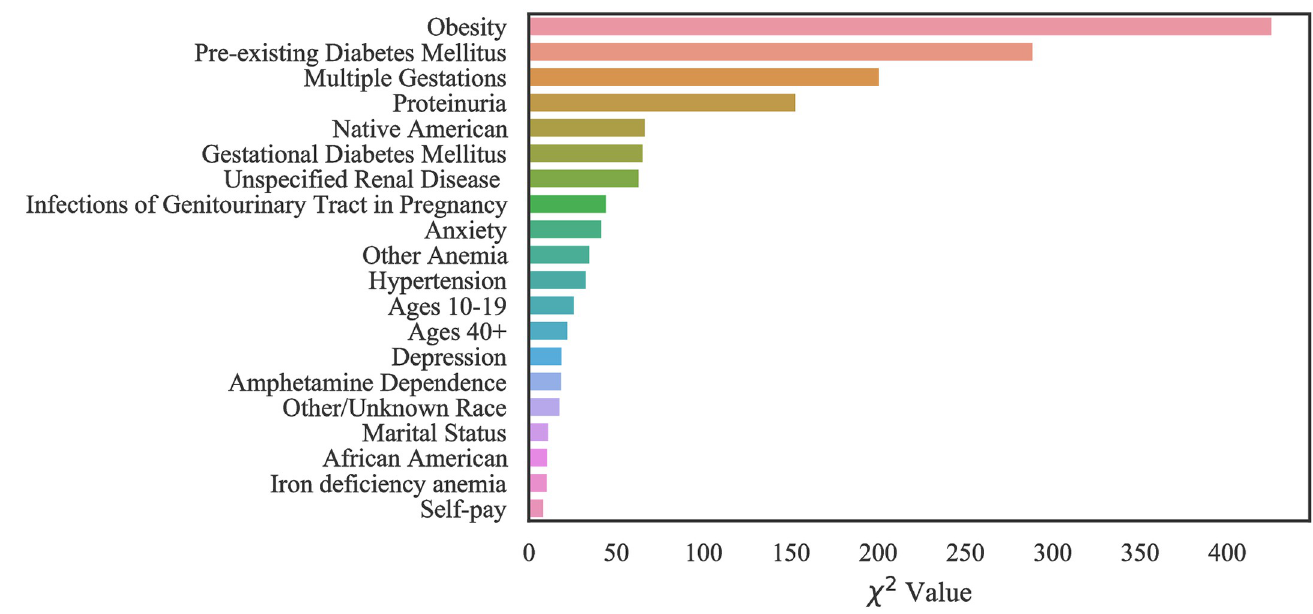
Fig 13. Feature ranking for the Full Oklahoma dataset.